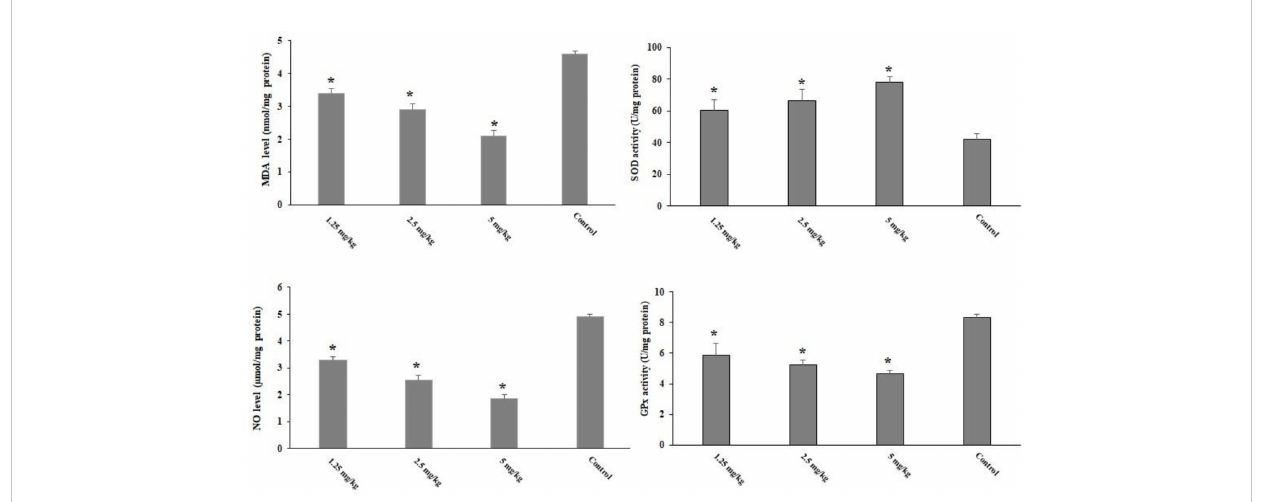
FIGURE 6 The level of hepatic malondialdehyde (MDA), nitric oxide (NO), glutathione peroxidase (GPx), and superoxide dismutase enzyme activity (SOD) in the Toxoplasma gondii -infected mice pre-treated with Curcuma longa essential oil (CLE) at the doses of 1.25, 2.5, and 5 mg·kg − 1 ·day − 1 in comparison with the control group. Data are expressed as the mean ± SD (n = 6). *p < 0.001.